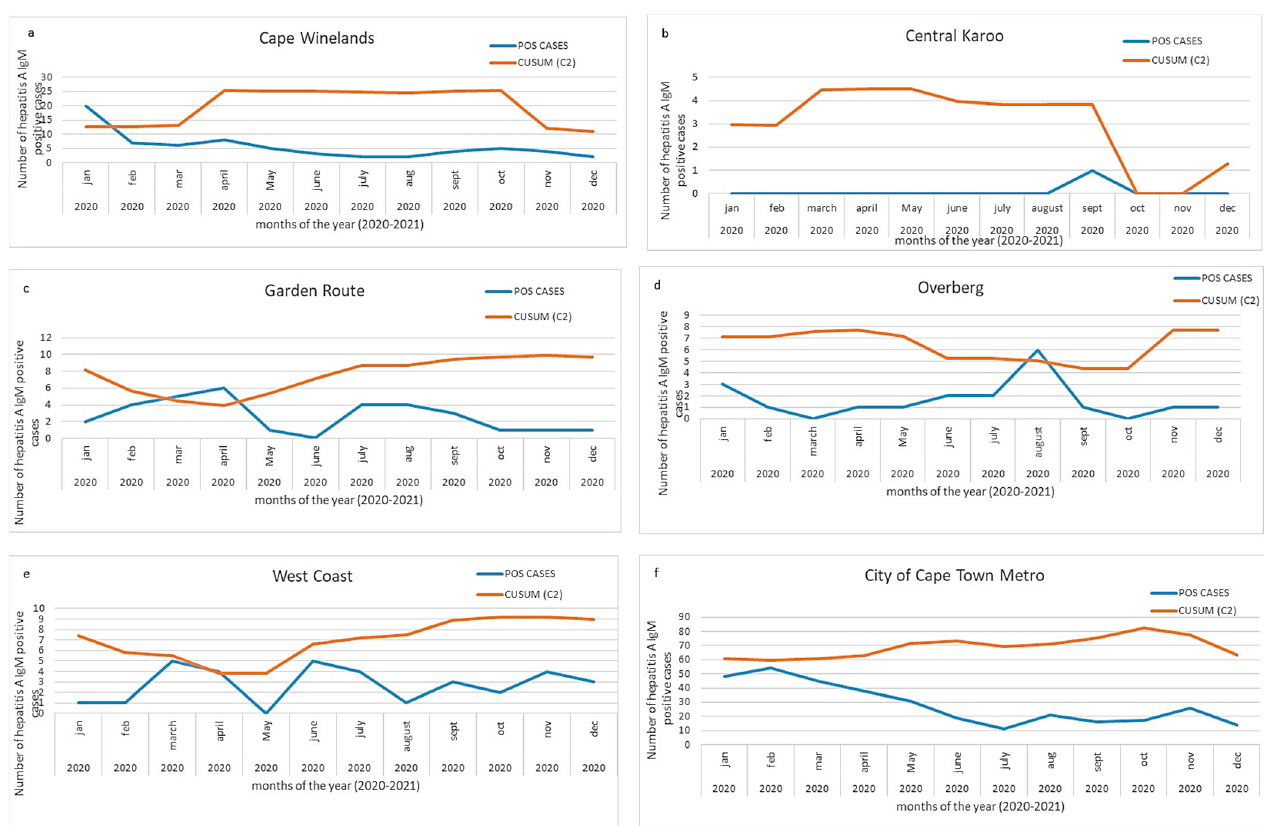
Figure 5. ( a – f ) Number of acute hepatitis A cases per district, Western Cape province, 2020. Number of acute hepatitis A cases (orange bars) are shown in comparison with the mean and two (black line) or three (red line) standard deviations of 2017–2019 data. A peak was noted in the Overberg district in August.